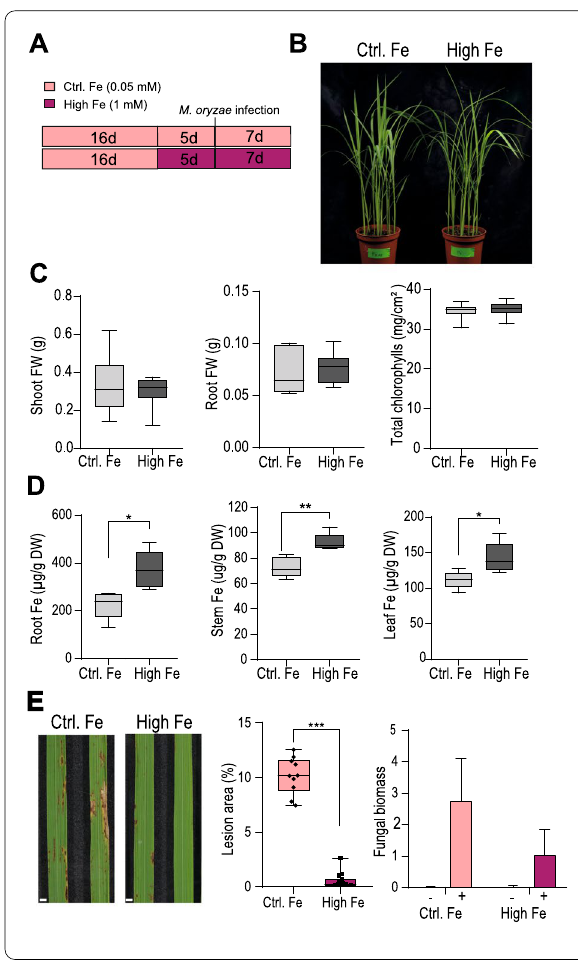
Fig. 1 Resistance to M. oryzae infection in rice plants grown under high Fe supply. A Experimental design used for iron treatment and infection with M. oryzae (5 10 5 spores/ml). Rice plants were grown × in soil for 16 days under sufficient Fe supply (50 µM Fe, Control plants) and allowed to continue growth under sufficient conditions (Ctrl) or high Fe conditions (1 mM Fe; High Fe) for 5 days more (left panel). Then, the rice plants were inoculated or not with M. oryzae spores and assayed for blast resistance. B Appearance of rice plants that have been treated with high Fe for 5 days. C Shoot and root fresh weight (FW, left and middle panels), and chlorophyll content (right panel) of plants treated with high Fe for 5 days. Differences were not statistically significant. D Total Fe content estimated by the ferrozine colorimetric method in roots, stems and leaves of Control and High Fe‑treated plants (5 days of treatment). Data are mean SEM (n 10). Asterisks indicate statistical significance ± = calculated by t ‑test (*, P < 0.05; **, P < 0.01). E Resistance to M. oryzae in Fe‑treated rice plants. Control and High Fe‑treated rice plants were inoculated with a conidial suspension of M. oryzae spores (5 10 5 × spores/ml), or mock‑inoculated. Left panel, Disease symptoms in youngest developed leaves (3rd leaf) at 7 days post‑inoculation (dpi) are shown. Results from one representative experiment of four independent experiments are presented. Middle panel, percentage of diseased area at 7 dpi (n 10). Right panel, fungal biomass was = quantified by qPCR using specific primers of the M. oryzae 28S ribosomal gene relative to the rice Ubiquitin 1 gene (Os06g46770) at 7 dpi, ( , mock‑inoculated; , M. oryzae ‑inoculated). Data are − + mean SEM (n 10). Asterisks indicate statistically significant ± = differences calculated by t ‑test (***, P < 0.001)